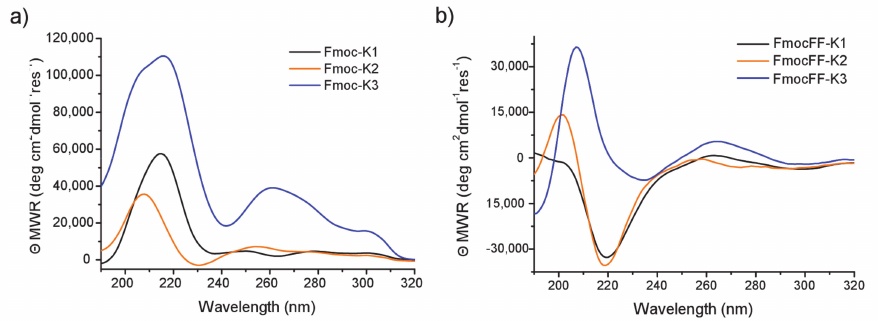
Figure 3. CD spectra of peptide solutions: ( a ) Fmoc-K1, Fmoc-K2, and Fmoc-K3 at 1.0 mg/mL, ( b ) FmocFF-K1, FmocFF-K2, and FmocFF-K3 at the maximum concentration of each peptide. All the spectra are recorded between 350 and 190 nm.